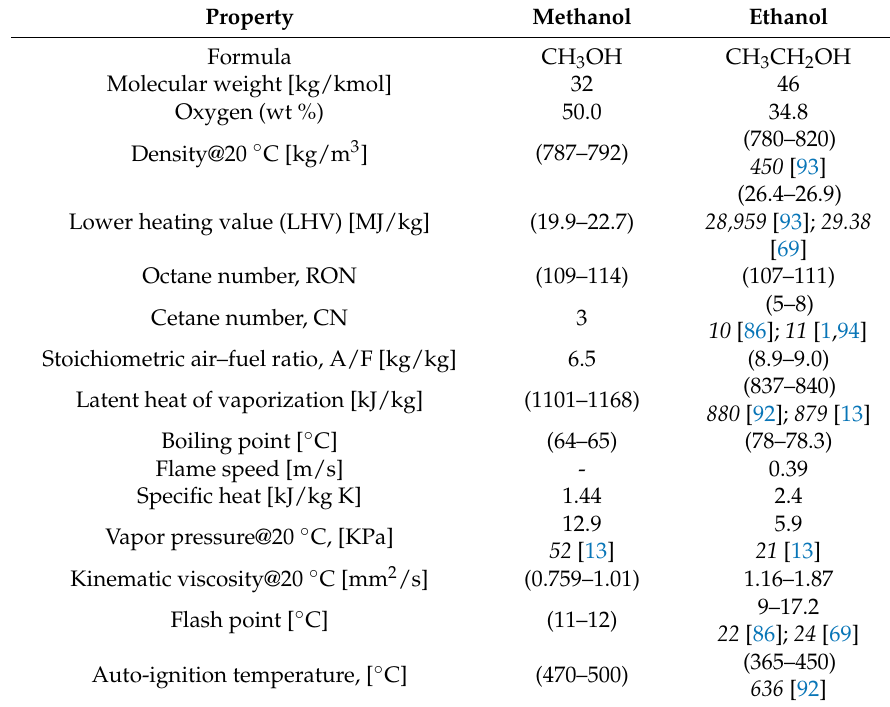
Table 6. Physical property values of ethanol and